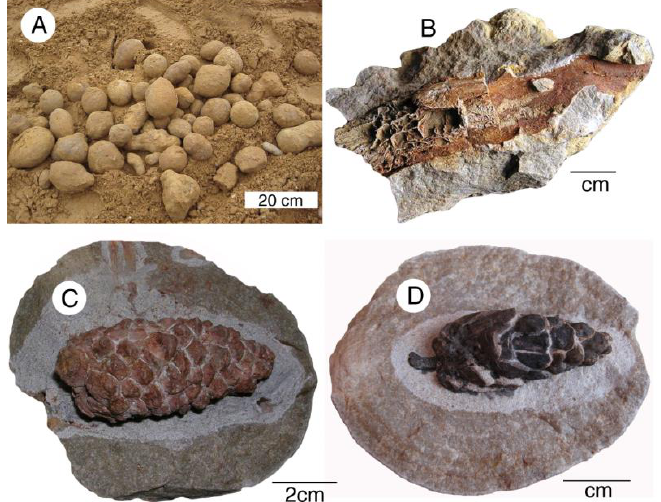
Figure 28. Fossiliferous nodules from Steinhardt Quarry. ( A ) Sandstone concretions gathered from quarry strata; ( B ) barite replacement of wood; ( C , D ) barite replacement of conifer cones.